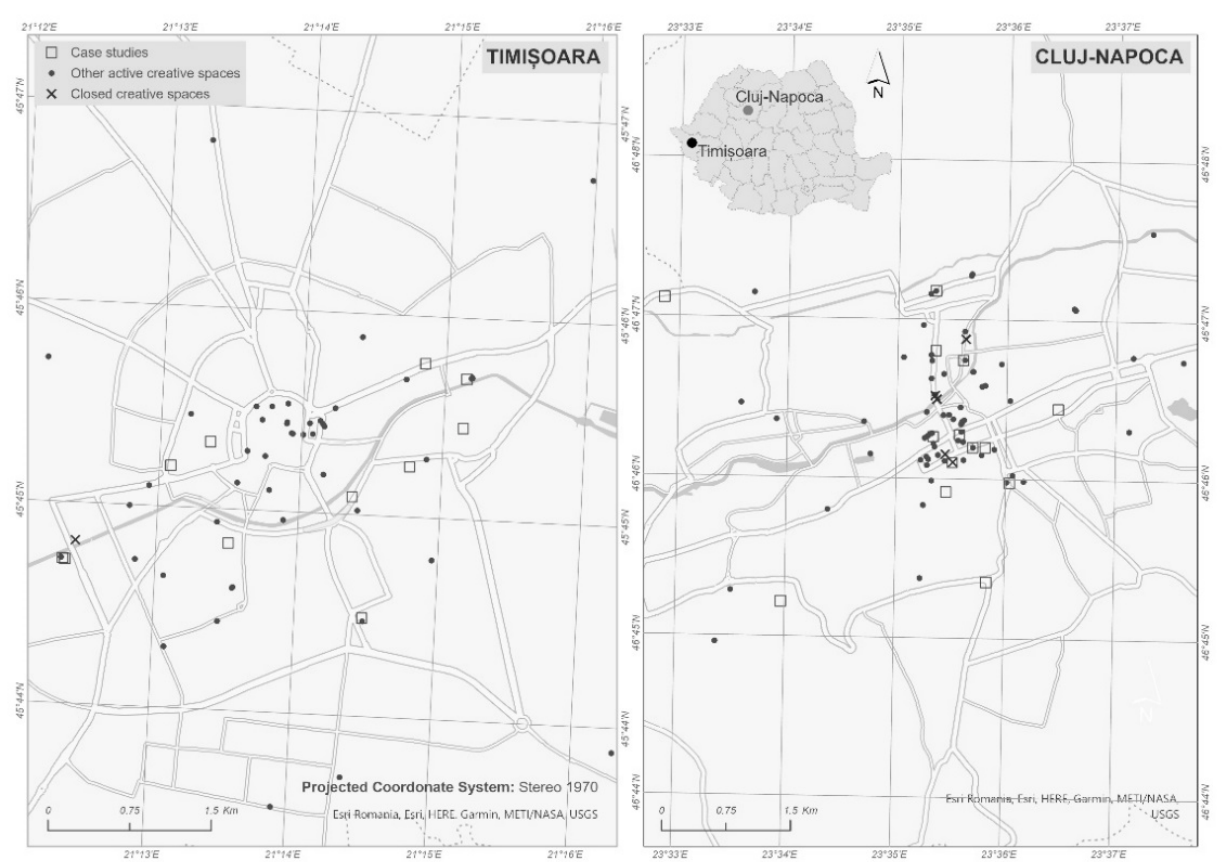
Figure 1. Location of creative and cultural spaces in Timi ș oara and Cluj-Napoca (2020).